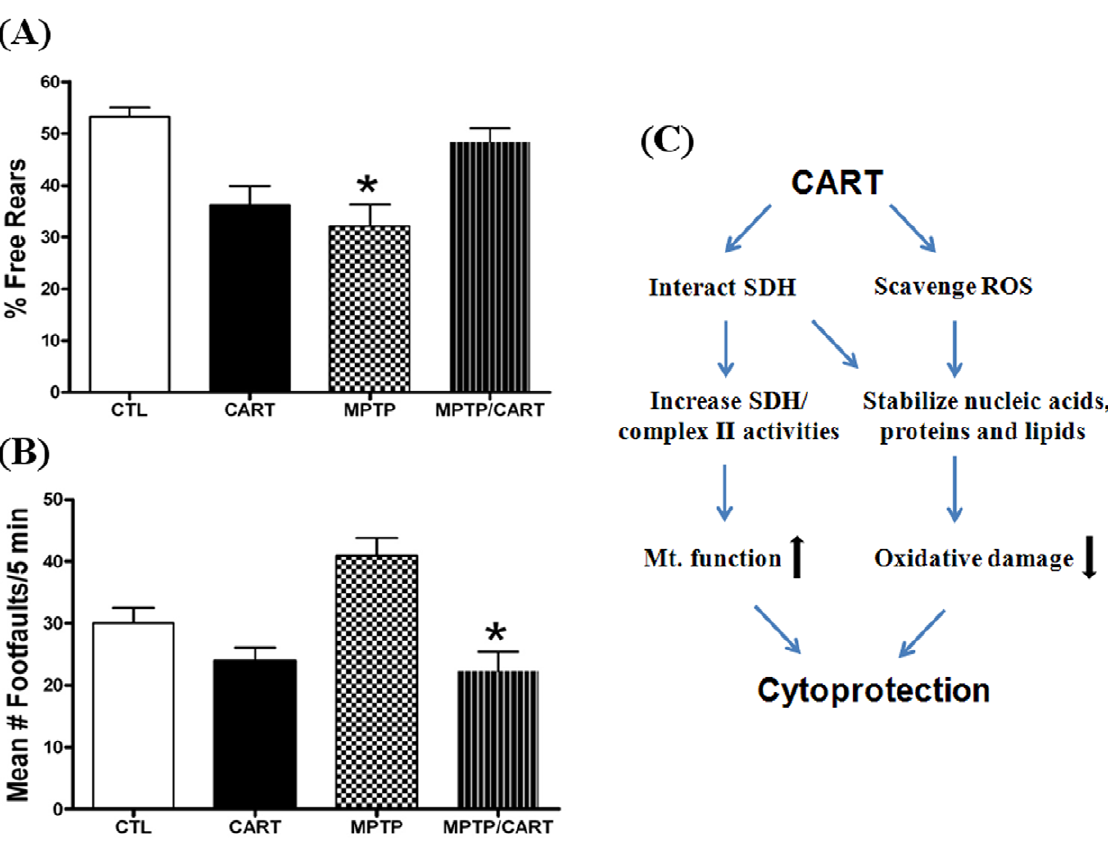
Figure 7. Effect of CART on motor behavior. ( A ) Percent free rears. The number of free versus wall-assisted rears was counted over a 5-minute period on day 8 after the last of the MPTP/CART/vehicle injections and the results presented as percent free rears. For the Control (CTL) group, there was nearly a 50/50 split in terms of the number of free versus wall-assisted rears. There was a decrease in the percent free rears for the CART only group, which was equivalent to that seen in the MPTP treated group. CART pretreatment reversed the MPTP-induced decrease in free rears to the levels seen in the control group. *, p , 0.05 compared to the CTL and MPTP/CART groups. ( B ) Number of foot-faults. The number of foot-faults during a 5-minute period was determined on day 8 after the last of the MPTP/CART/vehicle injections. CART pretreatment, then followed by MPTP, resulted in a significant decrease in the number of foot-faults compared to the MPTP only group. *, p , 0.05 compared to the MPTP group. ( C ) Schematic of mechanisms of CART action. Based on our data, CART peptide functions through at least two different and associated pathways, interaction with mitochondrial SDH and directly scavenging oxidants, ultimately preserving cells/neurons.